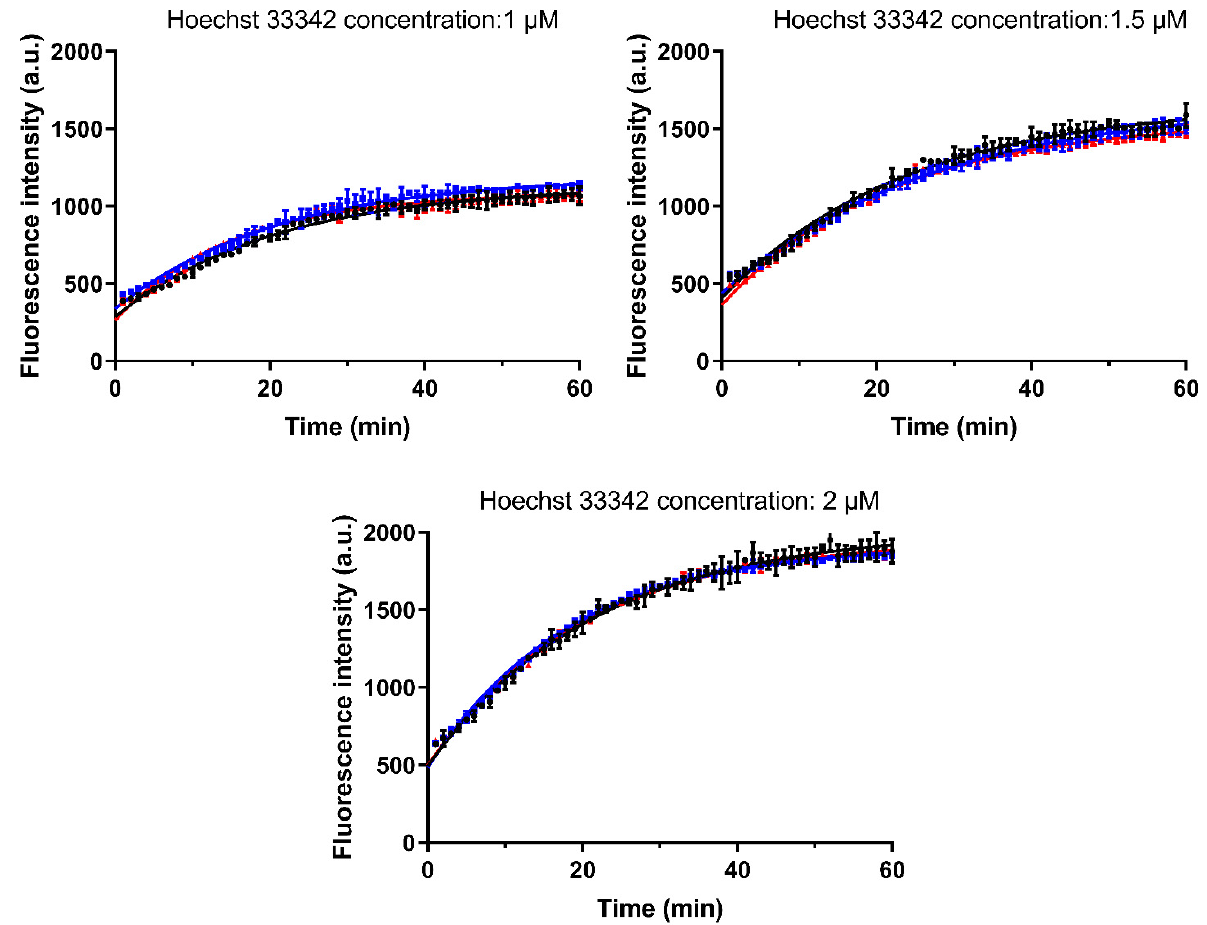
Figure 7. Accumulation kinetics of Hoechst 33342 alone and in the presence of CorA. Three different concentrations of Hoechst 33342 were incubated alone or together with CorA at different concentrations. ( ● ) no CorA, ( ■ ) CorA concentration of 3.16 µM and ( ▲ ) CorA concentration of 10 µM (mean ± SD, n = 3). Lines were fitted using the one-phase association fit.